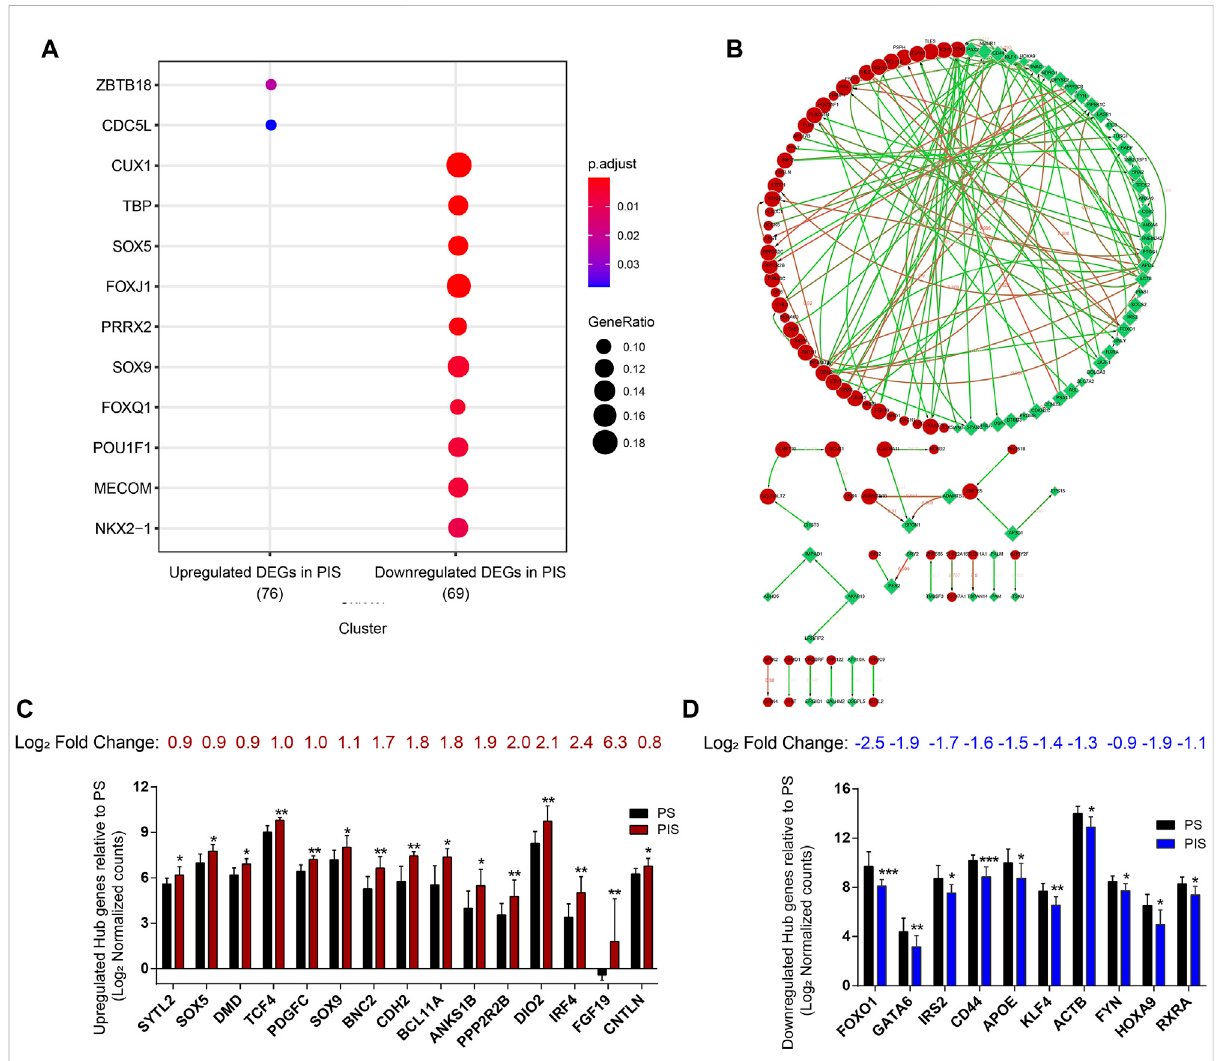
FIGURE 4 Bioinformatics analyses for screening the potential candidate genes. (A) Bubble diagram showing the transcription factor-binding sites clustered based on 230 overlapping DEGs. (B) Protein interaction networks were analyzed through STRING and Cytoscape analysis. Red nodes represent theupregulated overlappingDEGs,and green nodes represent thedownregulated overlapping DEGs inthePIS group compared to the PS group. The larger the node is, the higher the connectivity is. Edges between two nodes indicate potential interactions between two proteins encoded by corresponding DEGs. The higher the value around the edges between connected nodes is, the higher the credibility is. (C) Log 2 normalized counts of 15 upregulated candidate genes in the PIS group relative to the PS group. (D) Log 2 normalized counts of 10 downregulated candidategenesinthePISgrouprelativetothePSgroup.Abbreviations:DEGs,differentiallyexpressedgenes;PIS,progestininsensitive;PS,progestin